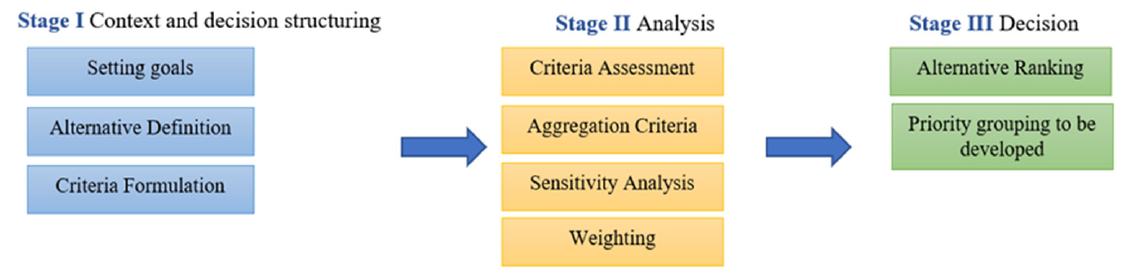
Figure 3. The process and stages of multicriteria analysis.